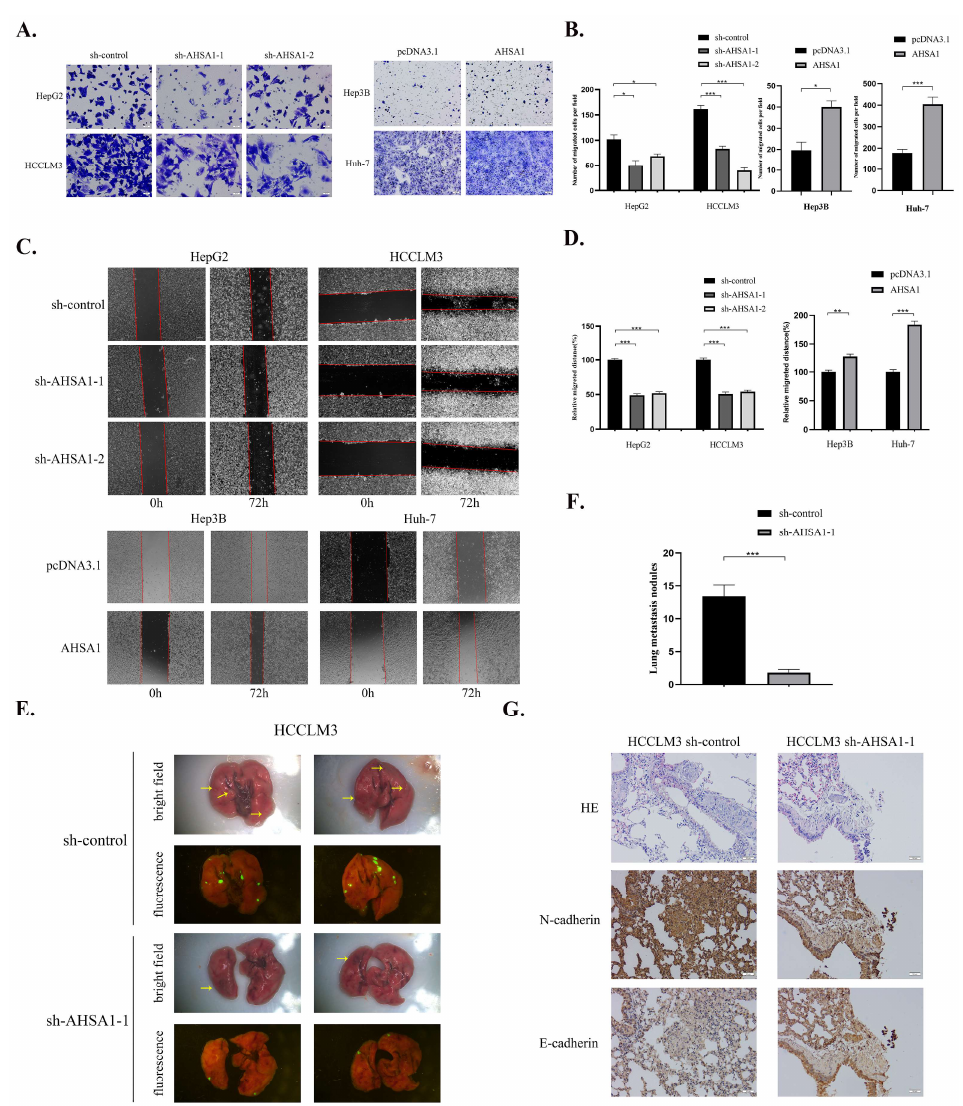
Figure 3. AHSA1 promoted the invasion, migration, and EMT of HCC both in vitro and in vivo ( A , B ). Representative images and quantitative analysis of Transwell assays in indicated HCC cell lines. ( C , D ). Representative images and the corresponding quantitative analysis of wound healing assays. ( E , F ). Representative images and quantitative analysis of the number of lung metastatic nodules in a nude mouse lung metastasis model by tail vein injection of indicated HCC cells; yellow arrow represents metastasis. ( G ). Representative images of HE and IHC staining of N-cadherin and E-cadherin in lung tissue of nude mice. *, p < 0.05; **, p < 0.01; ***, p < 0.001. To ascertain whether AHSA1 knockdown affects tumor metastasis in vivo, HCCLM3 cells transfected with AHSA1 knockdown lentivirus or control lentivirus were intra- venously injected into 6-week-old male nude mice via tail vein. All mice were eutha- nized after 58 days to analyze the effect of AHSA1 on tumor cell migration. As shown in Figure 3E,F, there were significantly fewer fluorescent tumor nodules in the lungs of mice injected with HCCLM3-sh-AHSA1-1, compared with those injected with HCCLM3- sh-control cells ( p <0.001). In addition, N-cadherin was downregulated and E-cadherin was upregulated in tumor tissues of mice injected with HCCLM3-sh-AHSA1-1, suggesting that